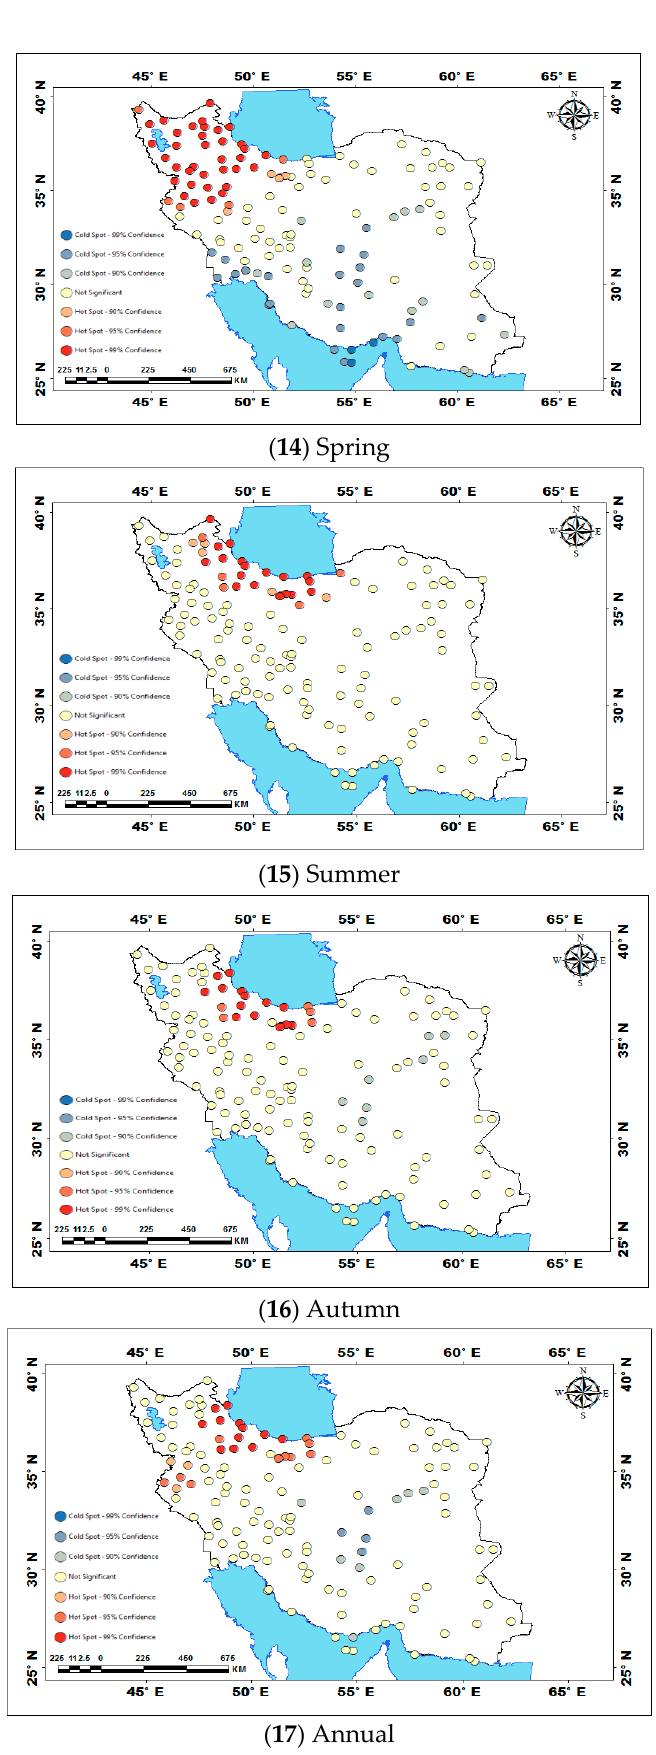
Figure 27. Gi statistics calculated monthly ( 1 – 12 ), seasonally ( 13 – 16 ) and monthly ( 17 ).